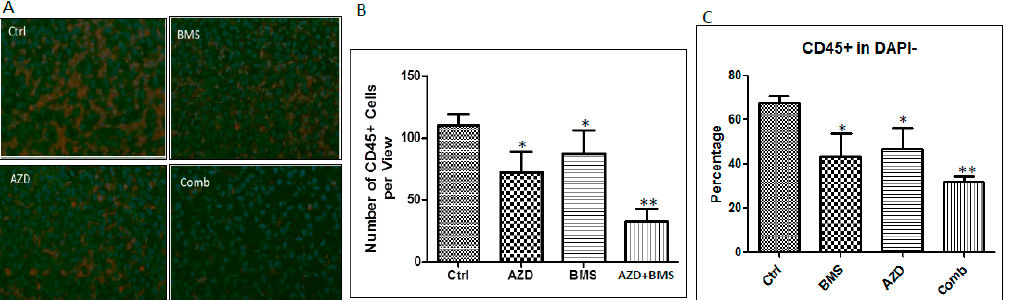
Figure 4. Regulation of CD45 + cell number by both MEK and Hh signaling pathways. ( A ) Representative immunofluorescent staining images of CD45 + cells in liver tissues after drug treatments. ( B ) Summary of A from 10 images in each group (from at least 3 mice) with the number of CD45 + cells per field under microscope (200×). ( C ) Summary of flow cytometry analysis of CD45+ cells in different treatment groups (from three mice/group). * indicates p < 0.05 and ** indicates a more than additive effect via BLISS independence analysis.